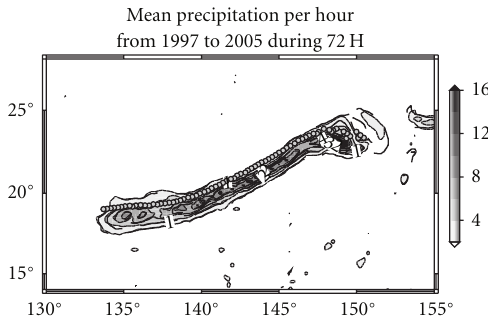
Figure 11: Horizontal distributions of mean hourly precipitation (mm) during 72 h among the nine NCM predictions (contours) and of the standard deviation (shading). Cumulative hourly precipitation was used to calculate the mean value.